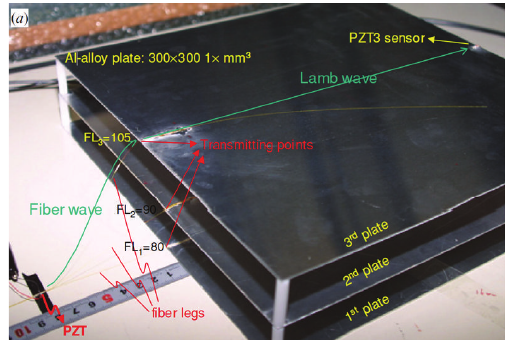
Figure 23: Experimental setup for ultrasonic transmission using a fiber wave PZT transducer (FL = fiber length between the PZT in the fiber wave PZT transducer and the remote transmitting point in mm). Three transmission paths, each in an individual plate, were explored simultaneously [13].